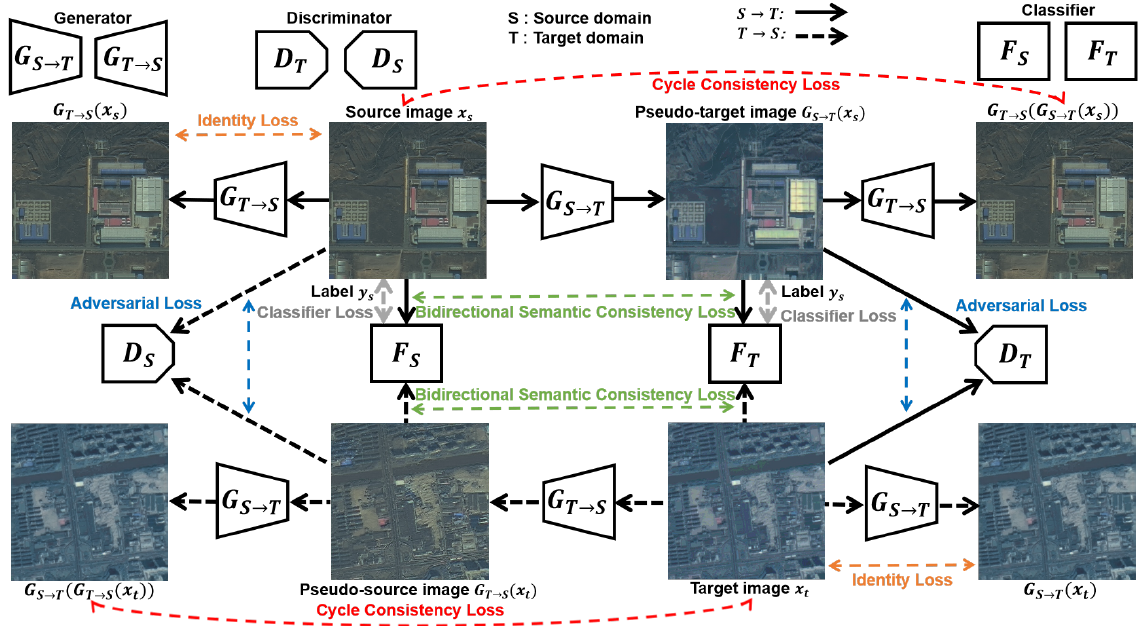
Figure 2. BiFDANet, training: The top row (black solid arrow) shows the source-to-target direction while the bottom row (black dashed arrow) shows the target-to-source direction. The colored dashed arrows correspond to different losses. The generator G s → T transfers the images to the pseudo-target images while the generator G T → S transfers the images to the source domain. D S and D T discriminate the images from the source domain and the target domain. F S and F T segment the images which are drawn from source domain and target domain,